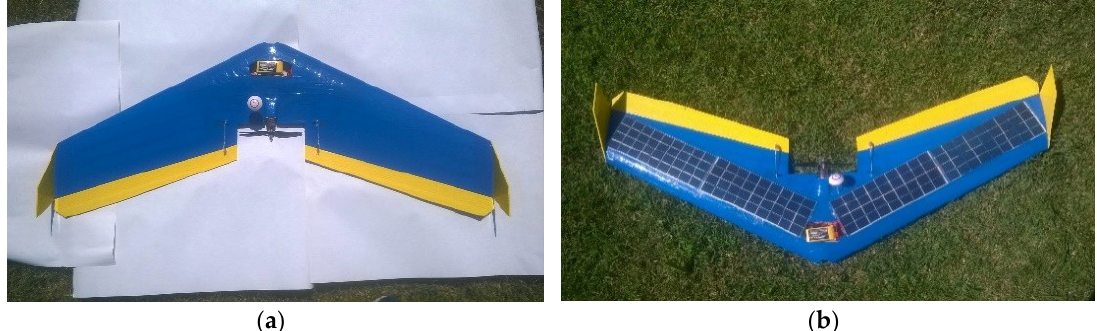
Figure 4. ( a ) Commercial model plane used for test and ( b ) commercial model with the added PV system for flight time prolongation.